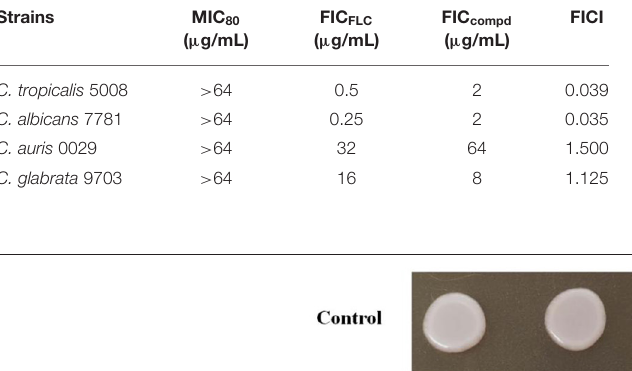
TABLE 3 | In vitro antifungal activity of ganetespib used alone or in combination with FLC against azole-resistant clinically isolated strains. Strains MIC 80